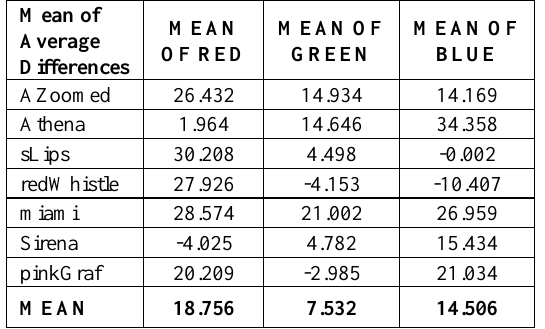
Table 2: Mean of Average Differences in radiometric values for Red, Green, Blue of the 6 De-mosaicking algorithms for every dataset.